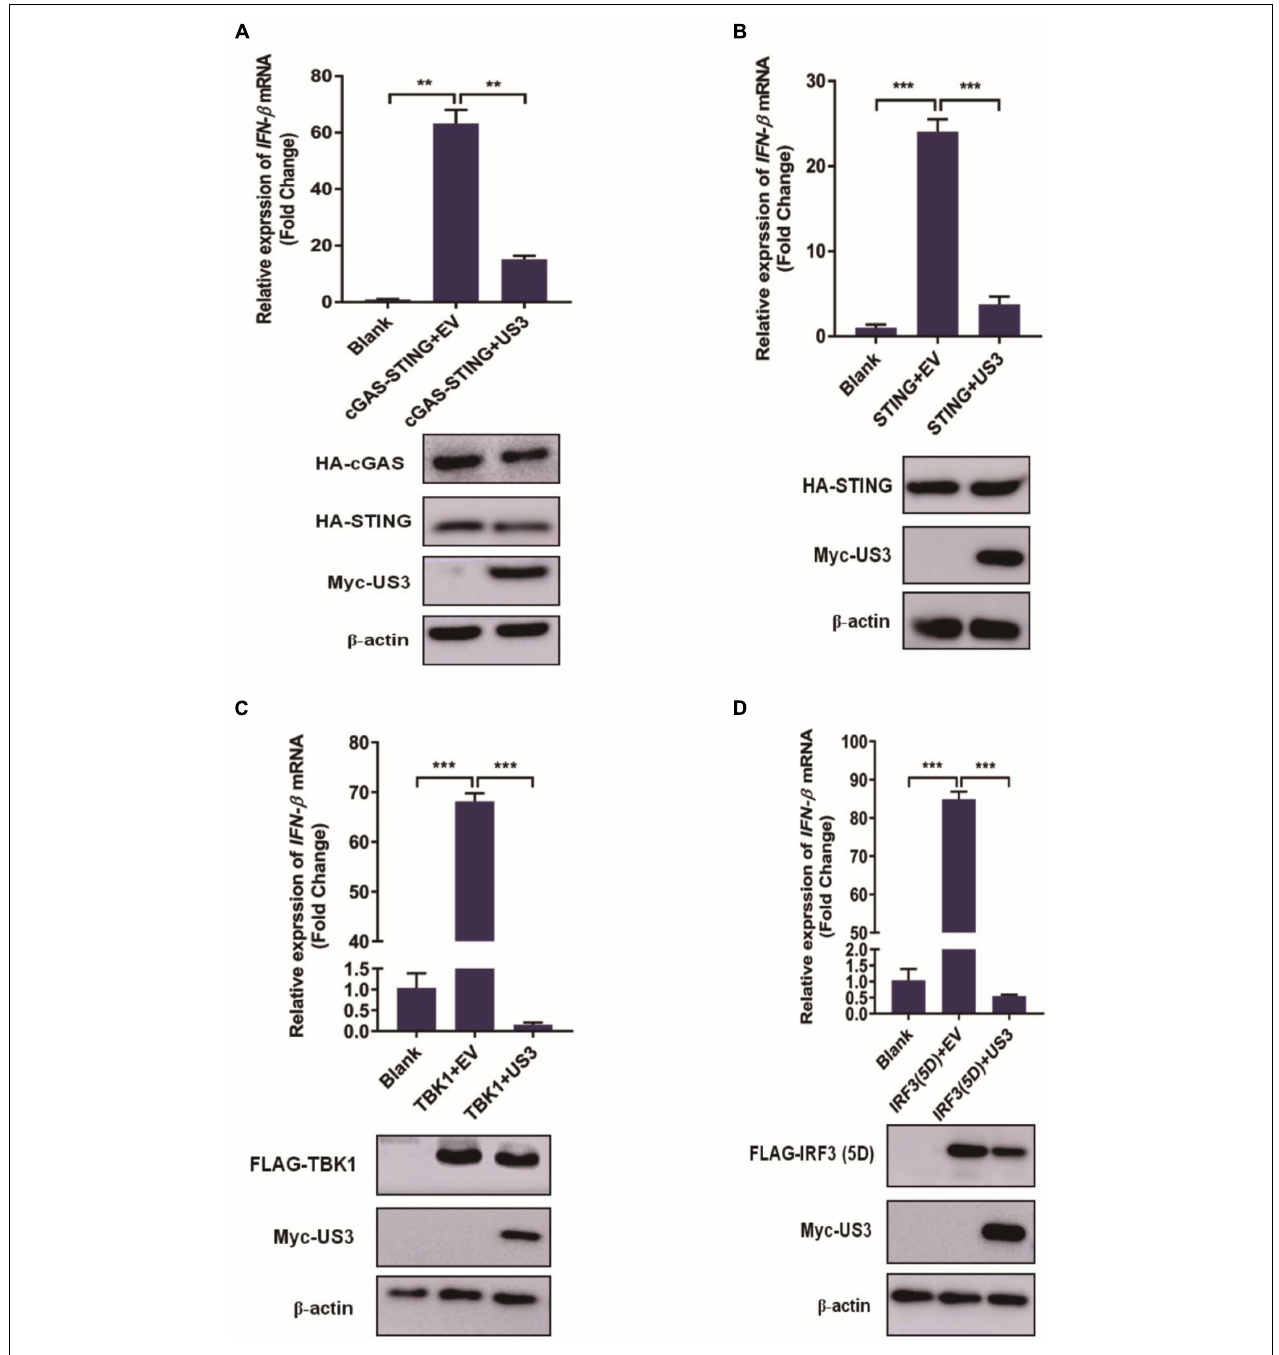
FIGURE 2 | PK15 cells were cotransfected with empty vector (0.5 µ g) or Myc-US3 (0.5 µ g) plasmids and the indicated plasmids expressing cGAS (15 ng) + STING (2.5 ng) (A) , STING (0.2 µ g) (B) , TBK1(0.2 µ g) (C) or IRF3(5D) (0.2 µ g) (D) for 24 h. Then cells were collected for total RNA extraction. IFN- β mRNA expression level was measured by RT-qPCR. Expression of various adaptor molecules and US3 protein was evaluated by western blotting. β -actin served as loading control. Data were listed as mean ± SD from three independent experiments. Comparison between two groups was evaluated by unpaired Student’s t test. ** p < 0.01, *** p <